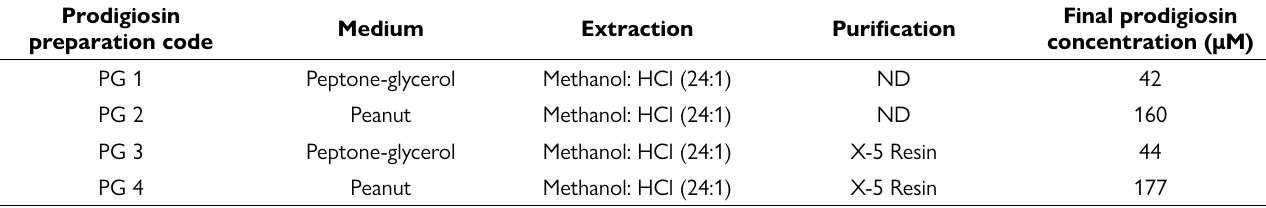
Table 1. Preparation of prodigiosin for experimental determination of antitrypanosomal and antibacterial action. Prodigiosin